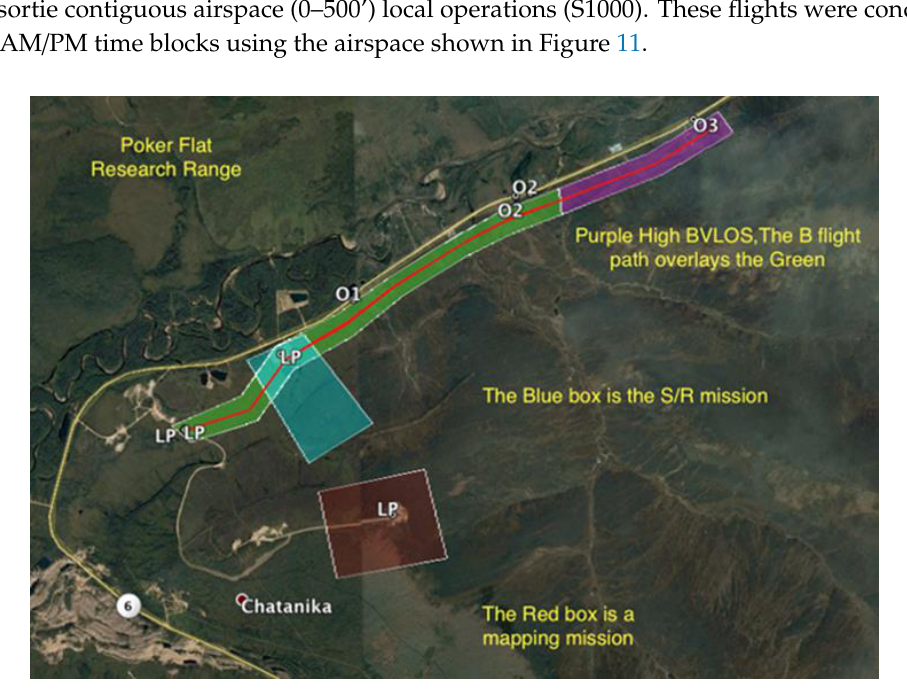
Figure 11. UAF TCL2 campaign at the Poker Flat Research Range (PFRR), May 2017. UAF assets included 1× each Ptarmigan S800, S900, S1000, ING Responder, and DJI Matrice 100, DJI Inspire [22] (p. 10).